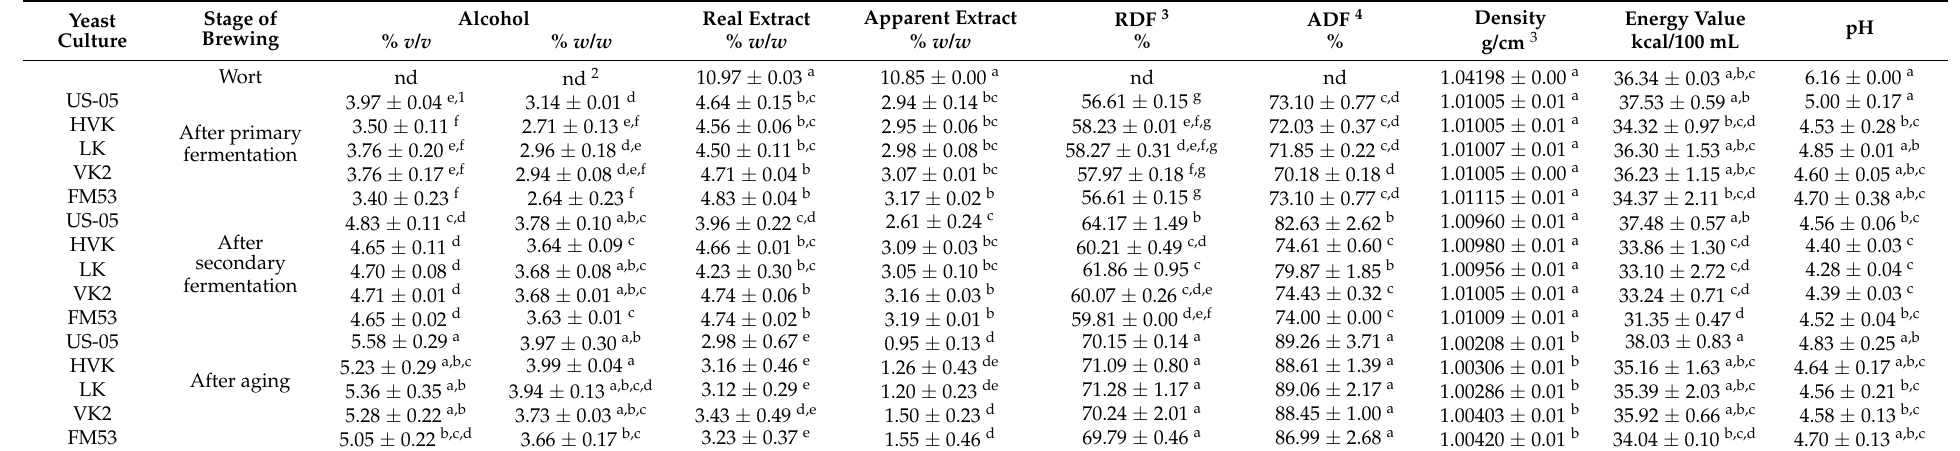
Table 1. Basic physicochemical parameters of beers at different production